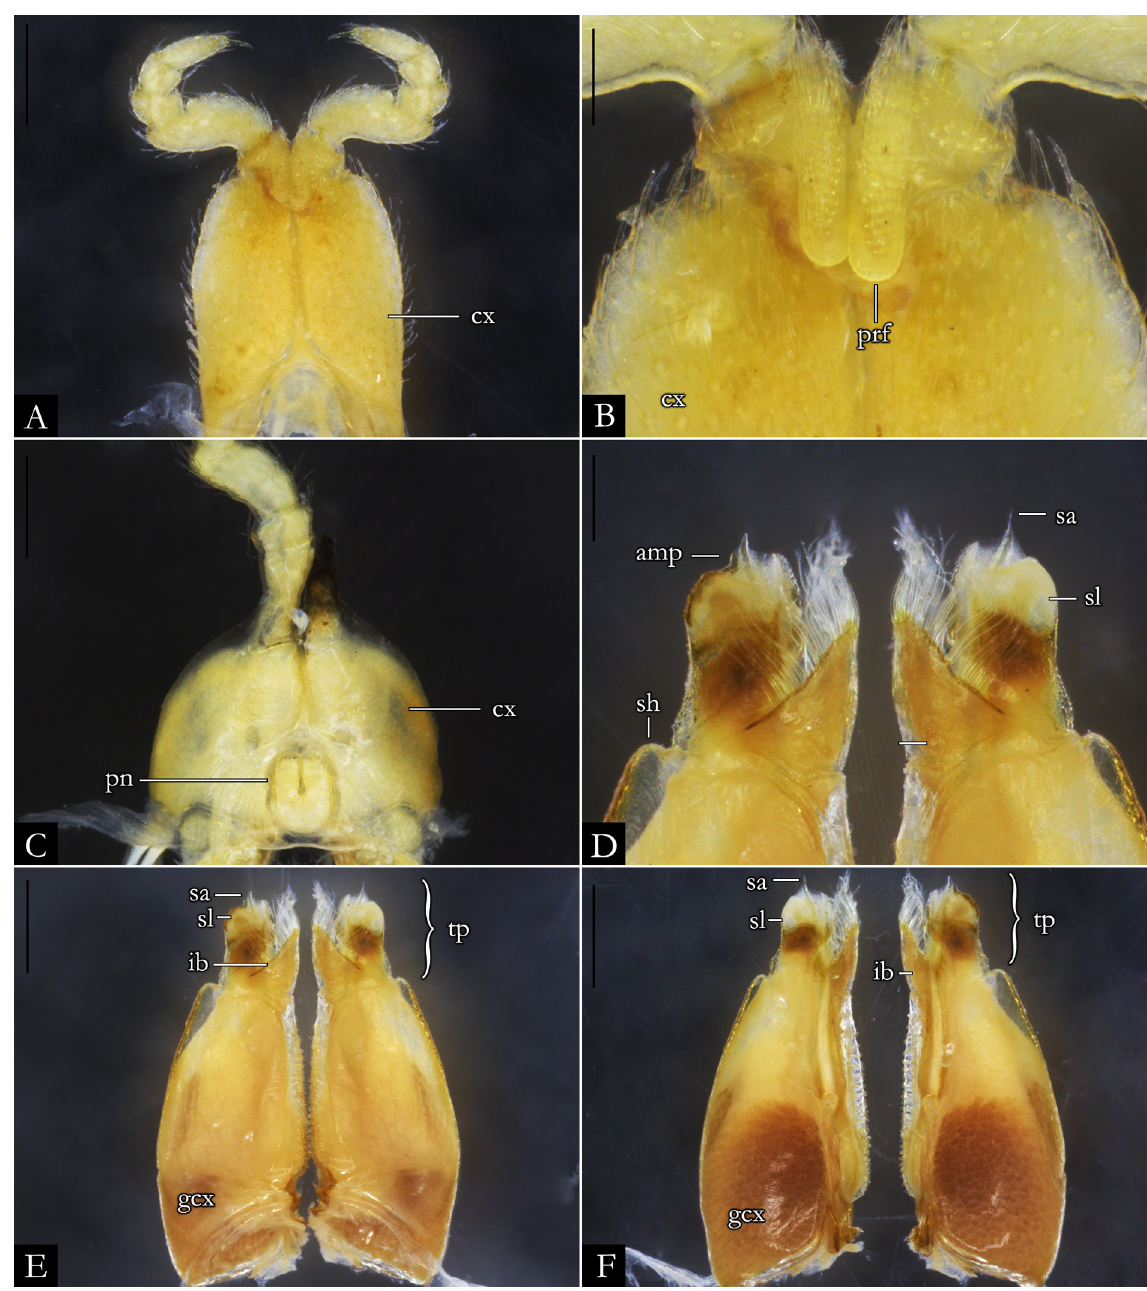
Fig. 122. Pseudonannolene sebastianus Brölemann, 1902, ♂ (IBSP 1390). A . First leg-pair. B . Detail of prefemur. C . Second leg-pair. D . Detail of telopodites, in anal view. E . Gonopods, in anal view. F . Gonopods, in oral view. Abbreviations: see Material and methods. Scale bars: A, C, E–F = 0.5 mm; B, D = 0.2